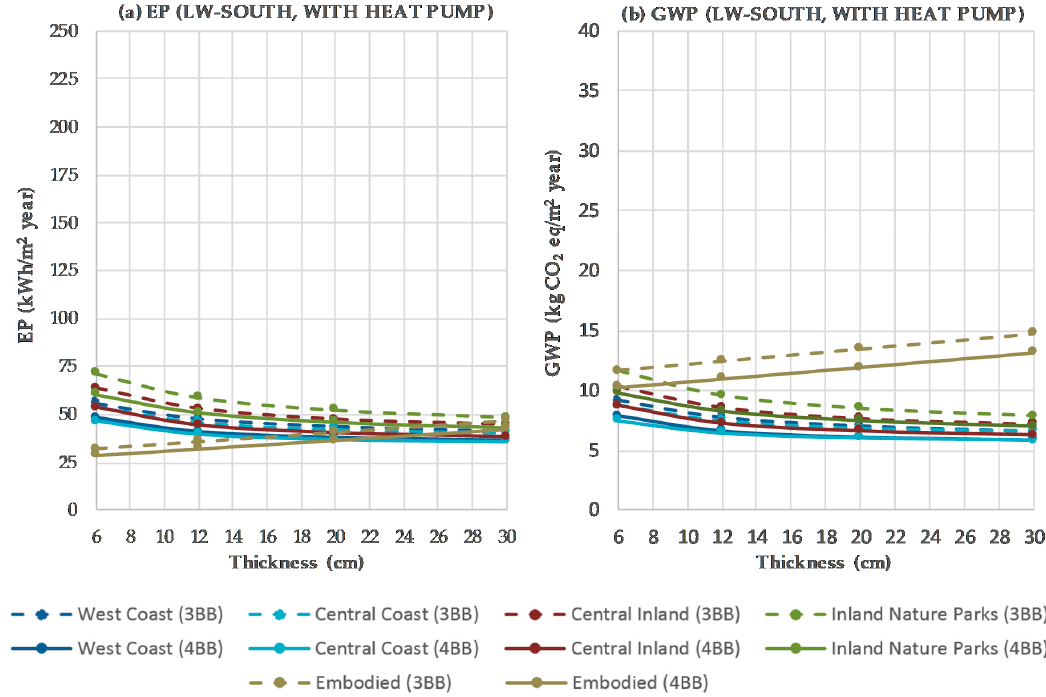
Figure 9. Embodied and use impacts of primary energy and CO 2 equivalent emissions for the heat pump plus electricity scenario, depending on insulation thickness, for the four locations, with LW-SOUTH both for 4BB and 3BB.